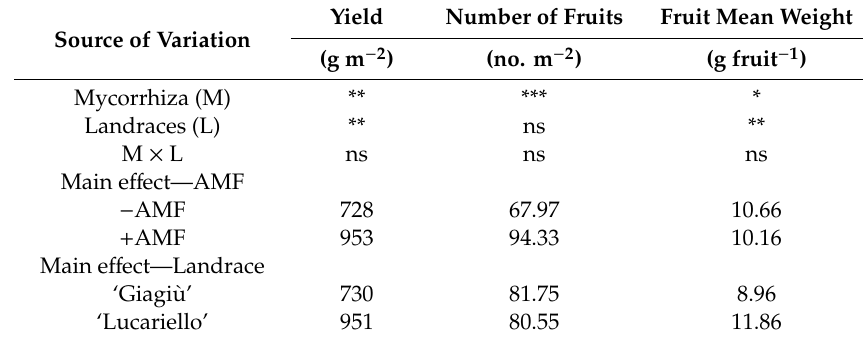
Table 1. Significance of the main e ff ects and their interactions on total yield, number of fruits and fruit mean weight. Values represent means of three